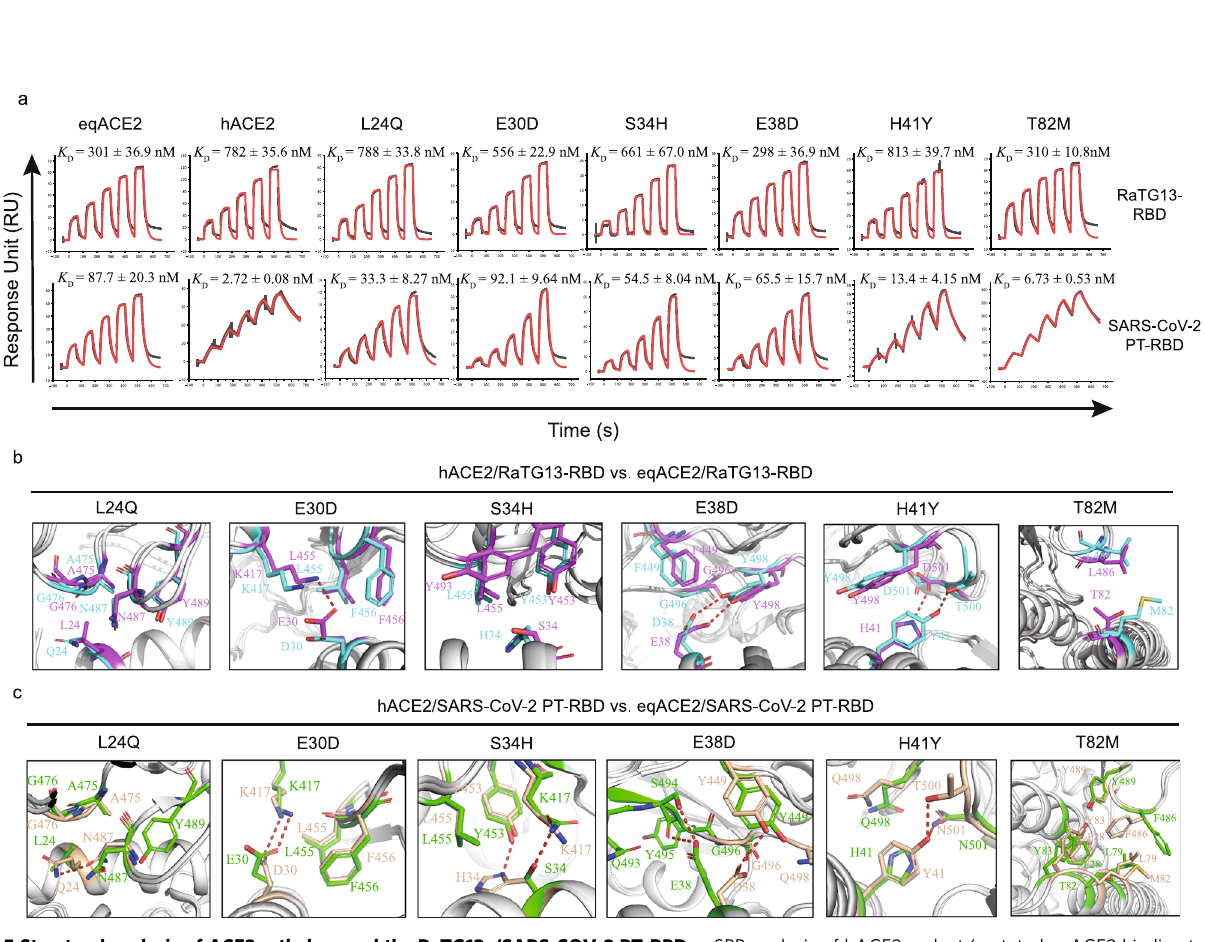
Fig. 5 Structural analysis of ACE2 orthologs and the RaTG13-/SARS-COV-2 PT-RBD. a SPR analysis of hACE2 and wt/mutated eqACE2 binding to the RaTG13-RBD or SARS-COV-2 PT-RBD. The dissociation constant ( K D ) of each binding test is calculated from 3 independent repeats and are presented as mean ± SD. Source data are provided as a Source Data fi le. b , c Structural comparison between equine and hACE2 binding to the RaTG13-RBD ( b ) or SARS- COV-2 PT-RBD ( c ). Residue substitution of the eqACE2/RaTG13-RBD, hACE2/RaTG13-RBD, eqACE2/SARS-COV-2 PT-RBD and hACE2/SARS-COV-2 PT-RBD are colored in purple, cyan, green, and wheat, respectively. Involved residues are shown as sticks in corresponding